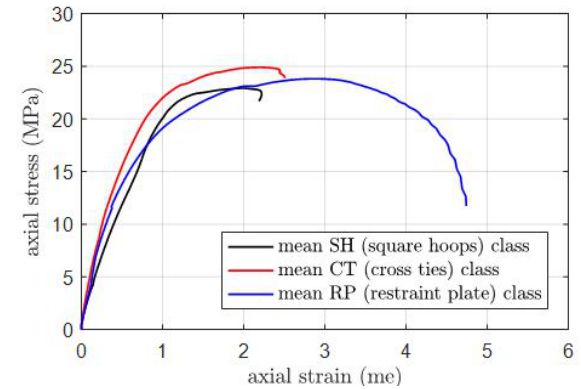
Figure 6: Compression test in accordance with UNI EN 12390-4 on concrete cube sample